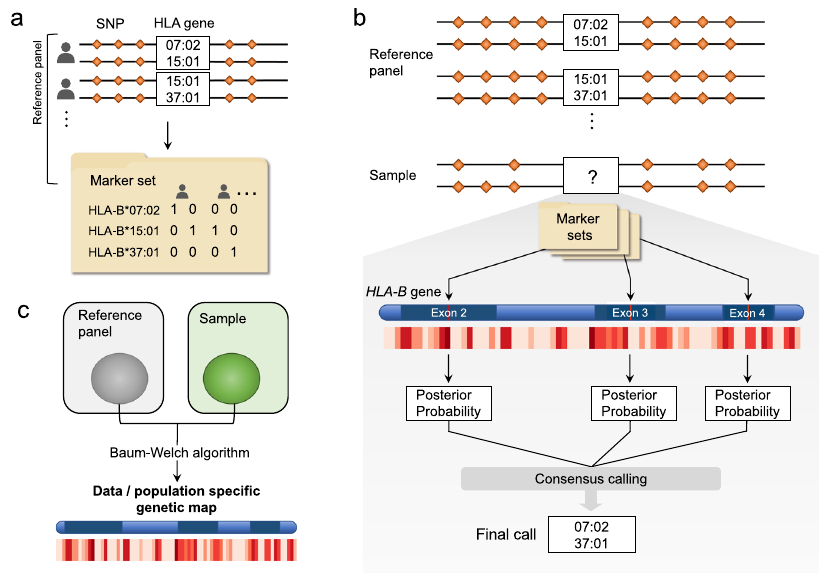
Fig. 1 Overview of CookHLA. a In the reference panel, CookHLA encodes HLA alleles as binary markers. b CookHLA repeats imputation while embedding a binary marker set into the middle position of each polymorphic exon. After the repeated imputations, CookHLA performs consensus calls by merging posterior probabilities. c CookHLA adaptively learns the data-speci fi c genetic map within the MHC from the data.